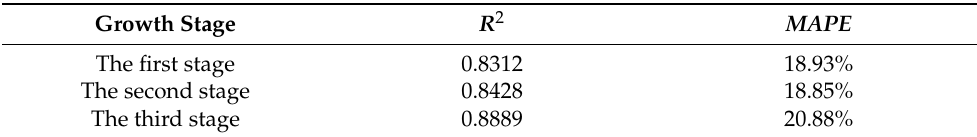
Table 10. R 2 and MAPE for the random forest plant height model.